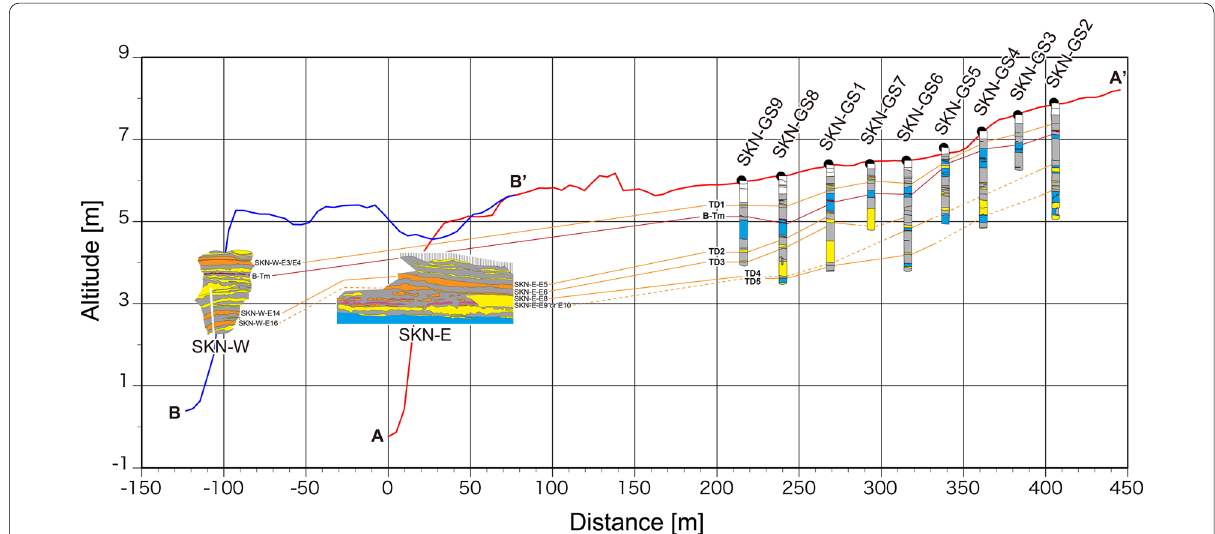
Fig. 11 Lateral correlation of tsunami deposits (TD1–TD5) between coastal outcrops and SKN-GS cores. A–A ′ and B–B ′ profile lines are shown in Fig. 1c. Vertical exaggeration is 25X. Sketches of SKN-E, SKN-W, and SKN-GS are from Figs. 2, 4, and 5, respectively. Sandy event deposits in orange in SKN-E and SKN-W indicate candidate tsunami deposits, showing relatively strong wave currents among the sandy event deposits in the outcrops